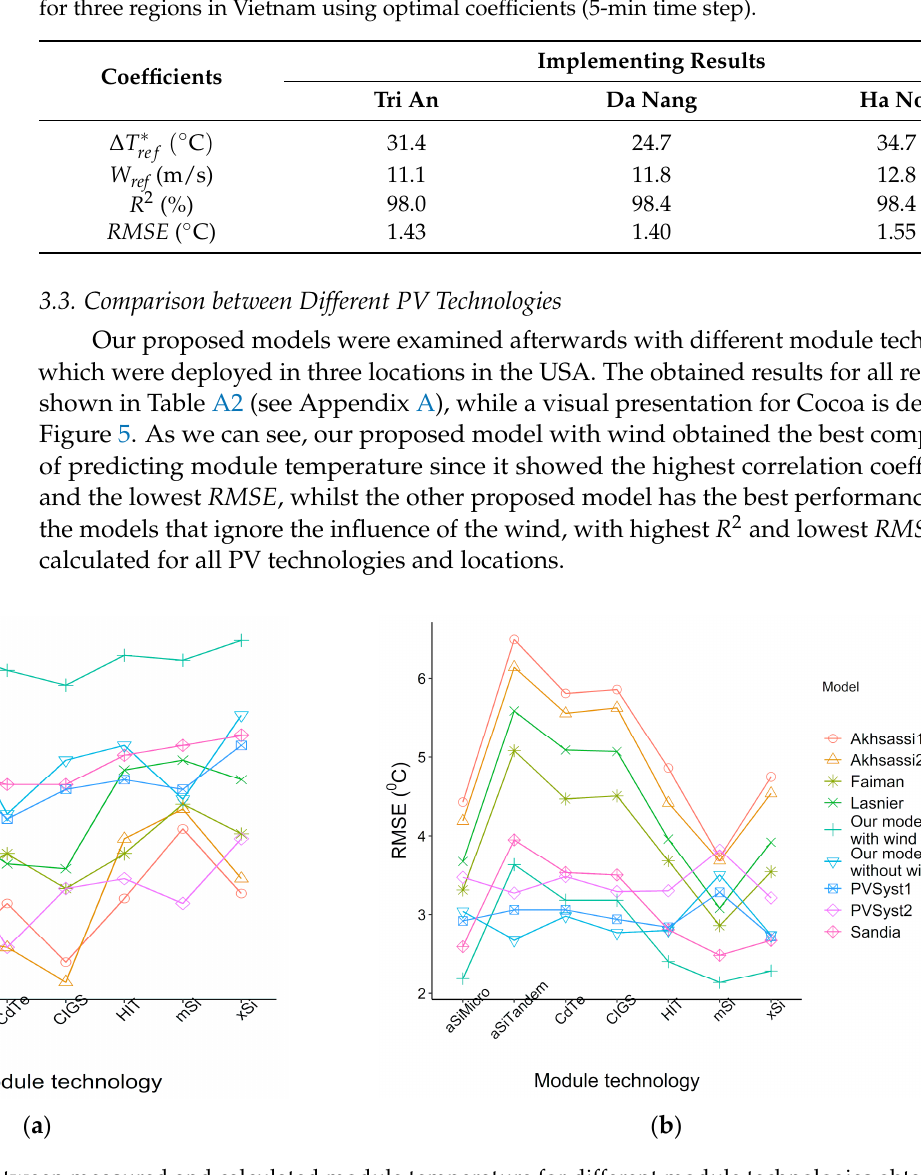
Table 6. Correlation coefficients ( (cid:1844) (cid:2870) and (cid:1844)(cid:1839)(cid:1845)(cid:1831) ) for measured and calculated module temperatures for three regions in Vietnam using optimal coefficients (5-min time step).